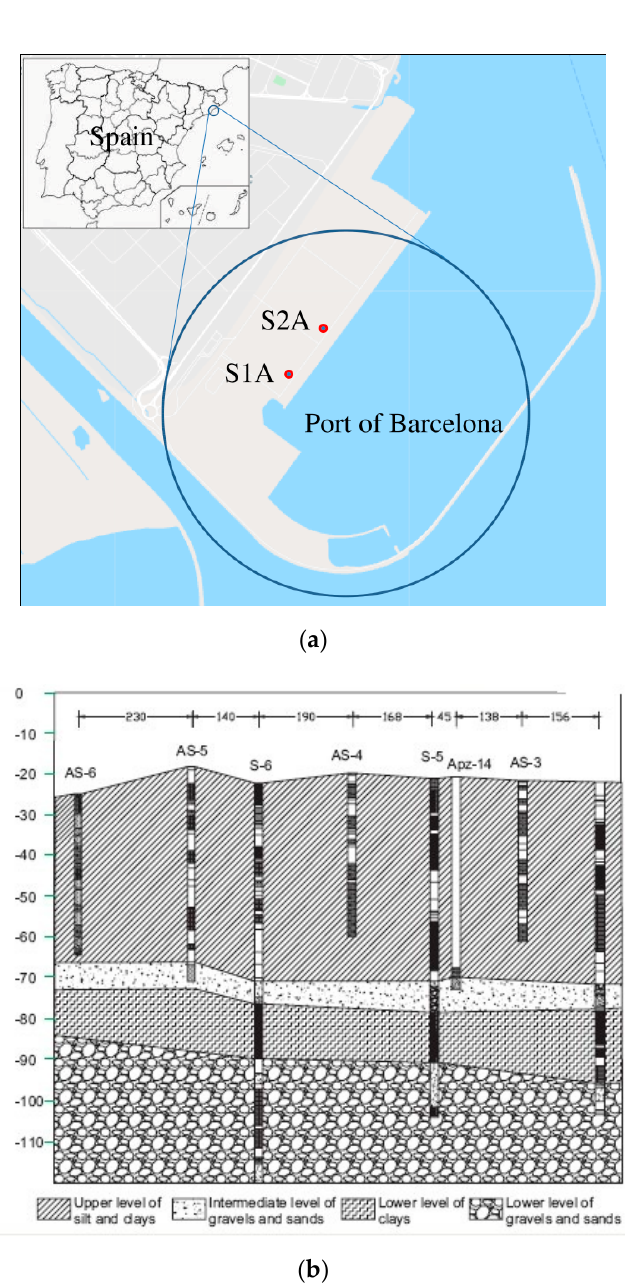
Figure 2. ( a ) Geographic location of the deposit where the samples were extracted and location of borings S1A and S2A drilled from the deck of Prat quay; ( b ) stratigraphic